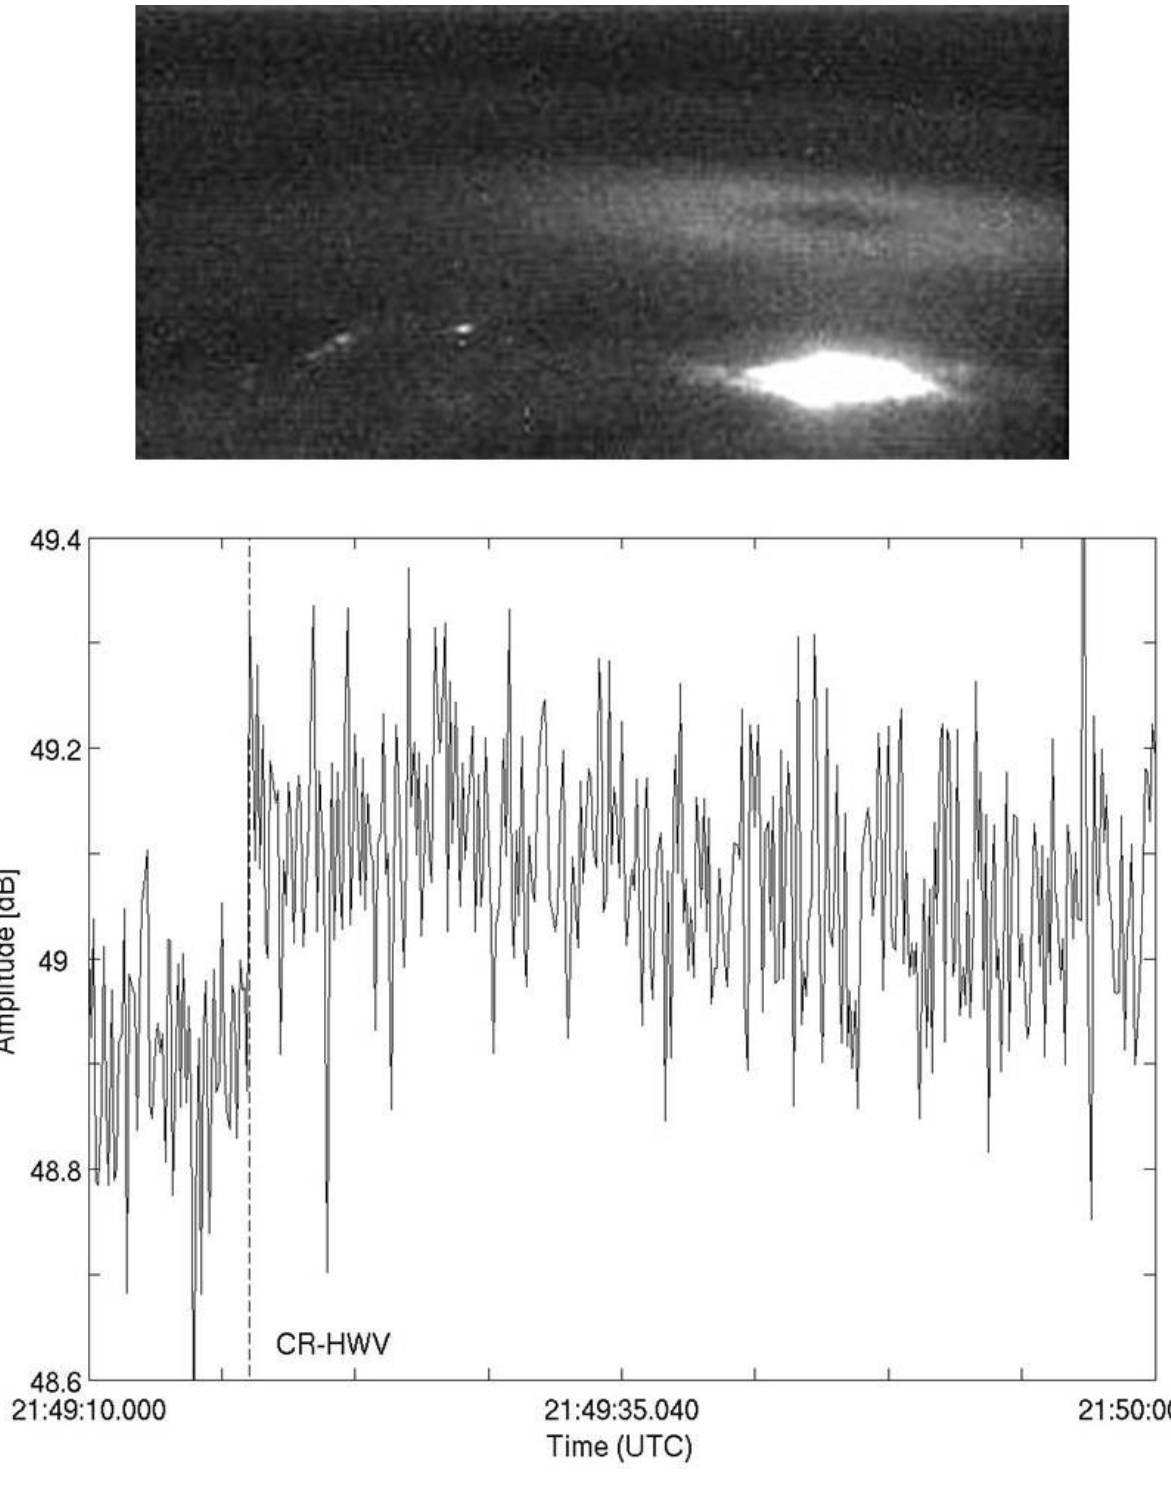
Fig. 5. Optical image of the elve (top panel) marked by ‘1’ in Fig. 4 and the associated early/fast VLF perturbation as seen in the HWV–Crete amplitude time series (bottom